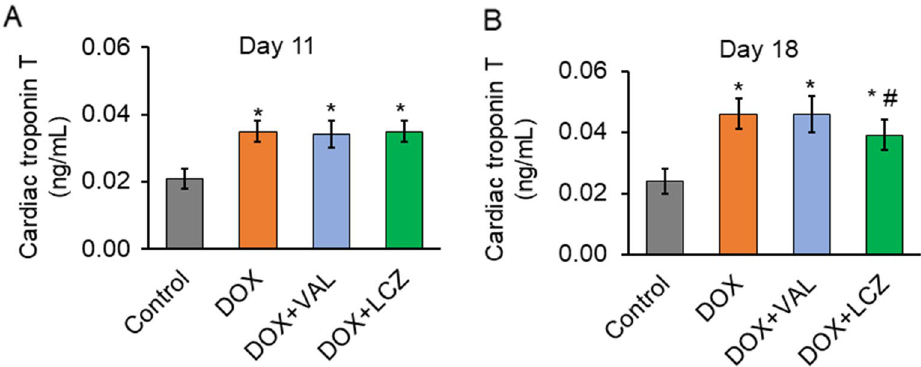
Figure 1. Effect of valsartan and LCZ696 on the serum cardiac troponin T levels in doxorubicin-treated rats. ( A ) On day 11, DOX significantly increased the serum cardiac troponin T level, which did not differ from that in the DOX + VAL and DOX + LCZ groups. n = 15 in each group. ( B ) On day 18, the increased serum cardiac troponin T level in the DOX group was significantly reduced in the DOX + LCZ group, but not in the DOX + VAL group. n = 10–15 in each group. Data are expressed as the mean ± standard error. * p < 0.05 versus control and # p < 0.05 versus DOX. MDA, malondialdehyde; DOX, doxorubicin; VAL, valsartan; LCZ,